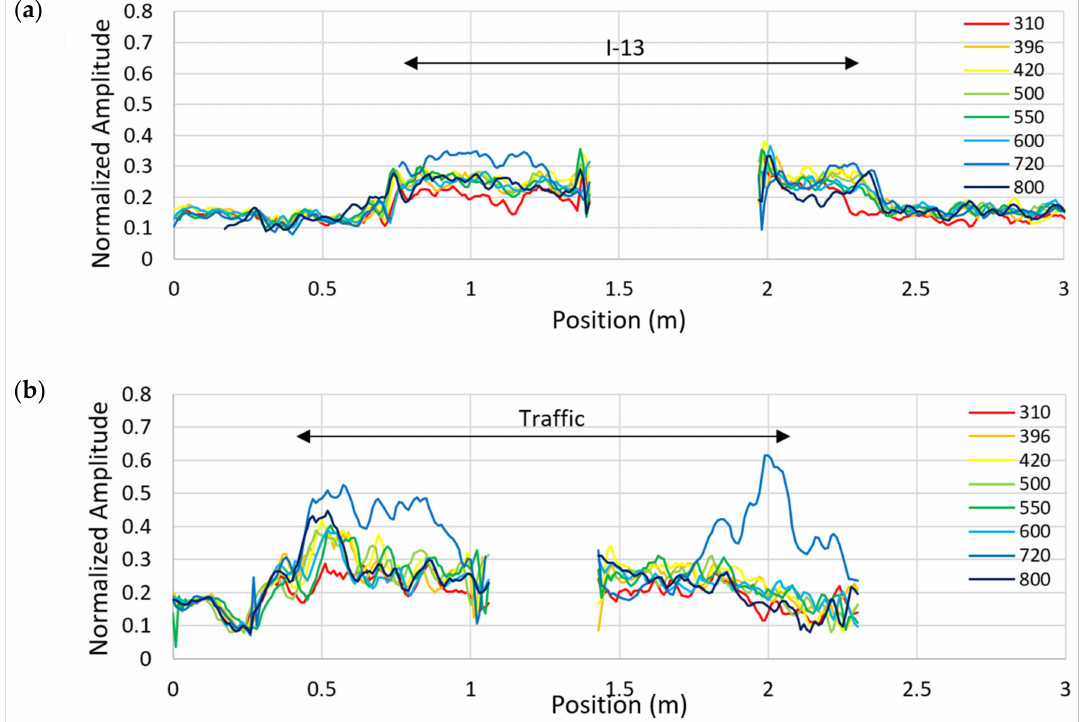
Figure 18. 1.5 GHz Norm. RW amplitudes on tack-coat free (I-13) in the ( a ) long. and ( b ) transv. direction vs. K loadings.